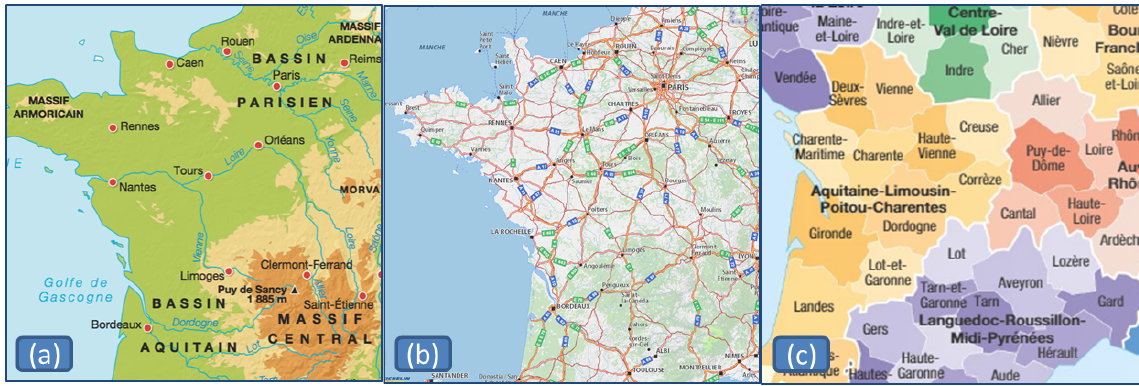
Figure 6: Three maps of with different types of content: (a) cities, relief, and hydrography (b) cities, roads, and vegetation (c) adminis- trative boundaries.